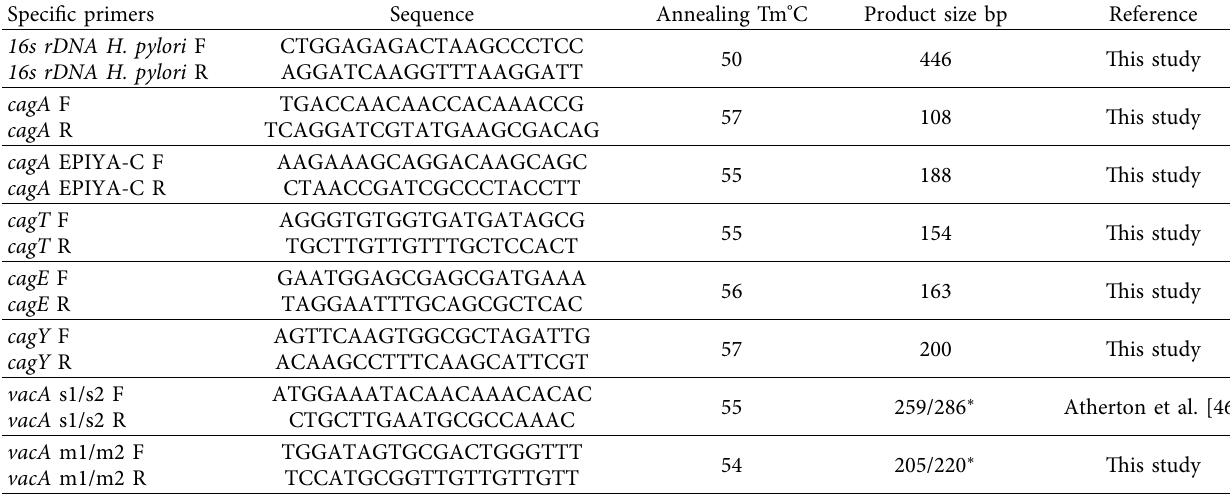
Table 1: Primers of H. pylori T4SS, 16s rDNA, and vacA in simple PCR.